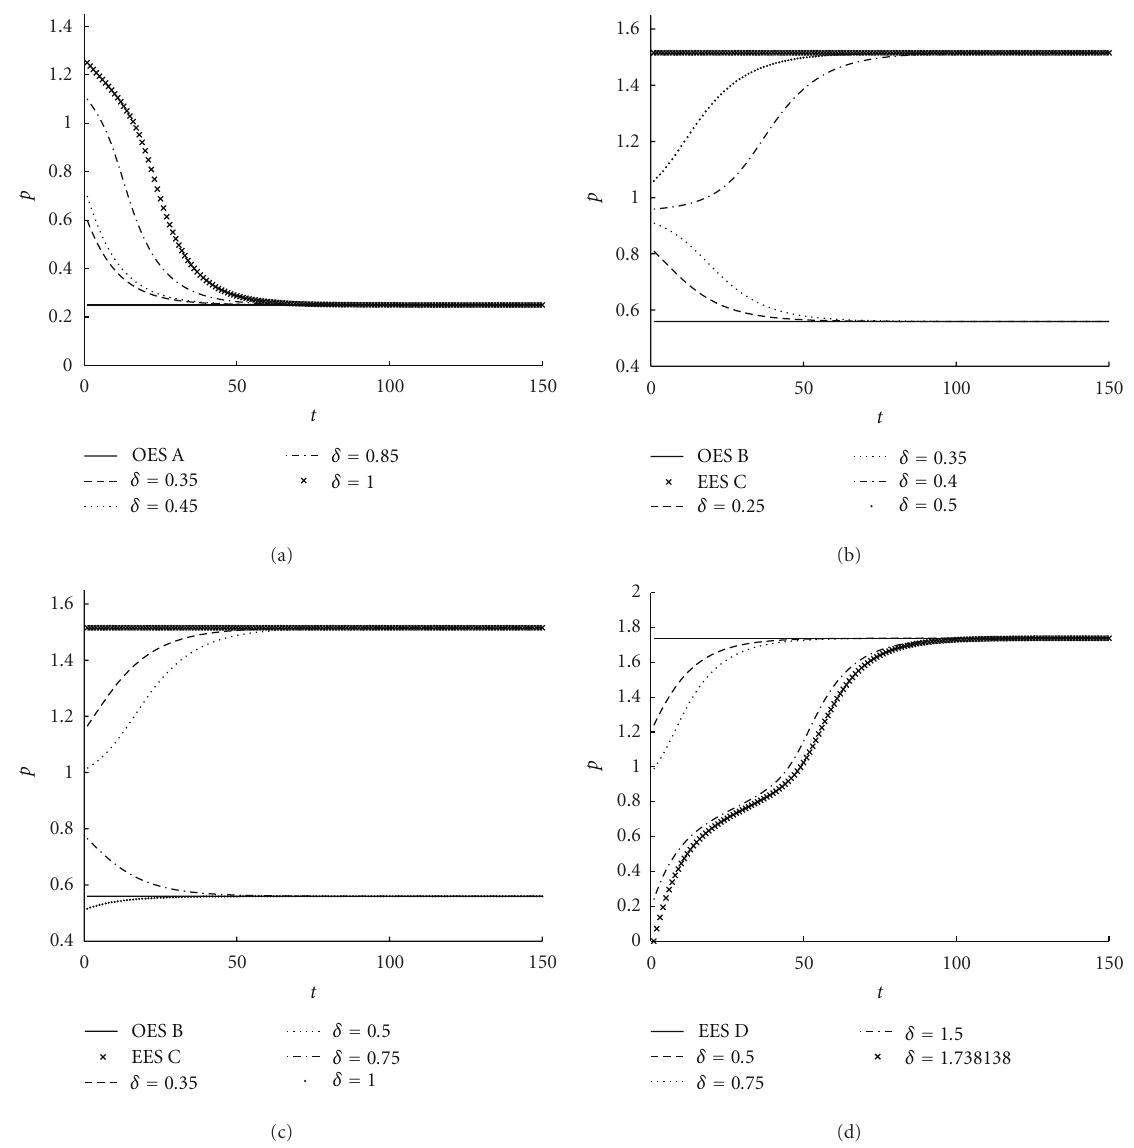
Figure 2: The 15-year nonlinear evolution of the lake ecosystem, with p 0 + CNOP-I as the initial condition and c as the control parameter. (a) c = 0 . 25, the basic state is OES A; (b) c = 0 . 55, the basic state is OES B; (c) c = 0 . 55, the basic state is EES C; (d) c = 0 . 75, the basic state is EES